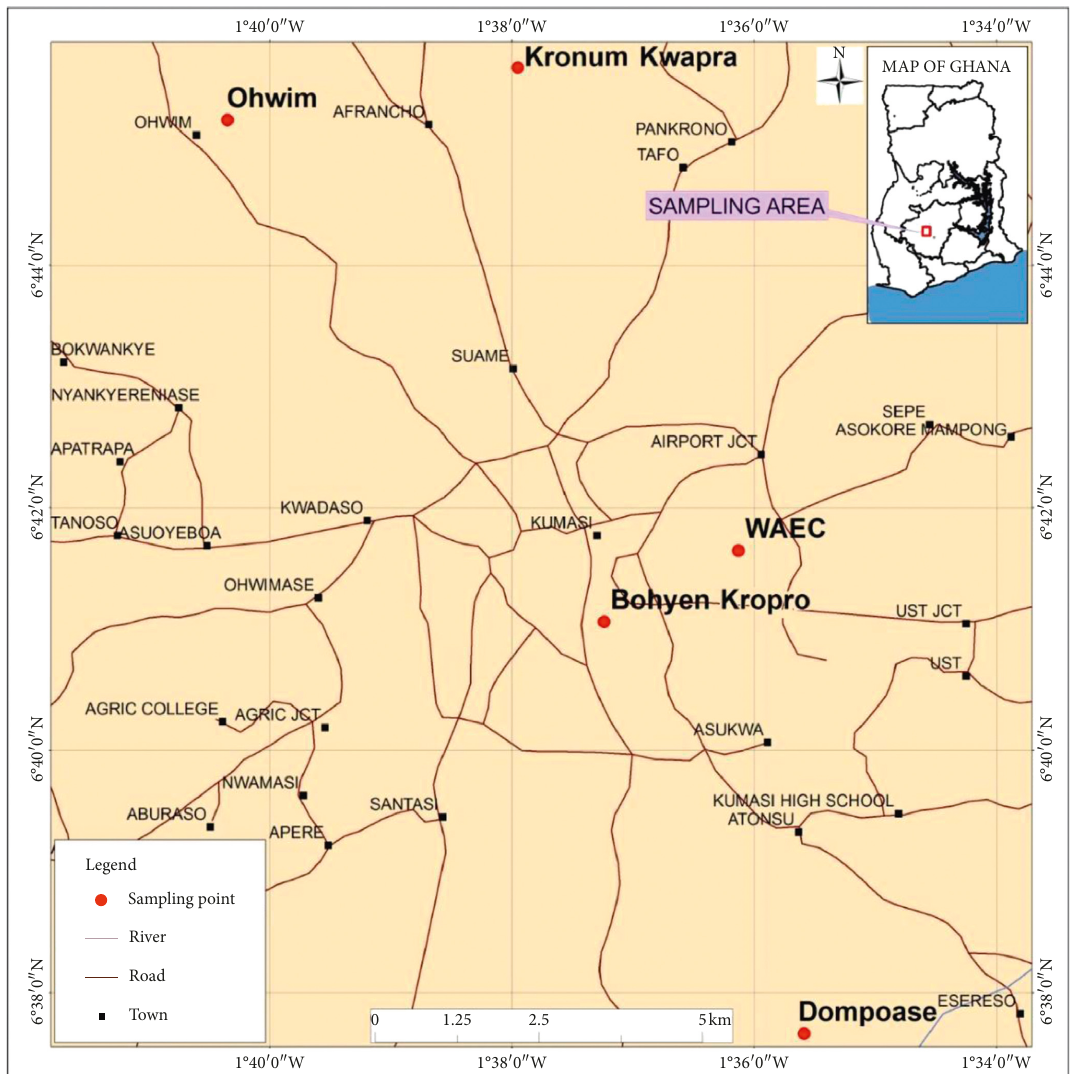
Figure 1: Map of Kumasi metropolis showing sampling